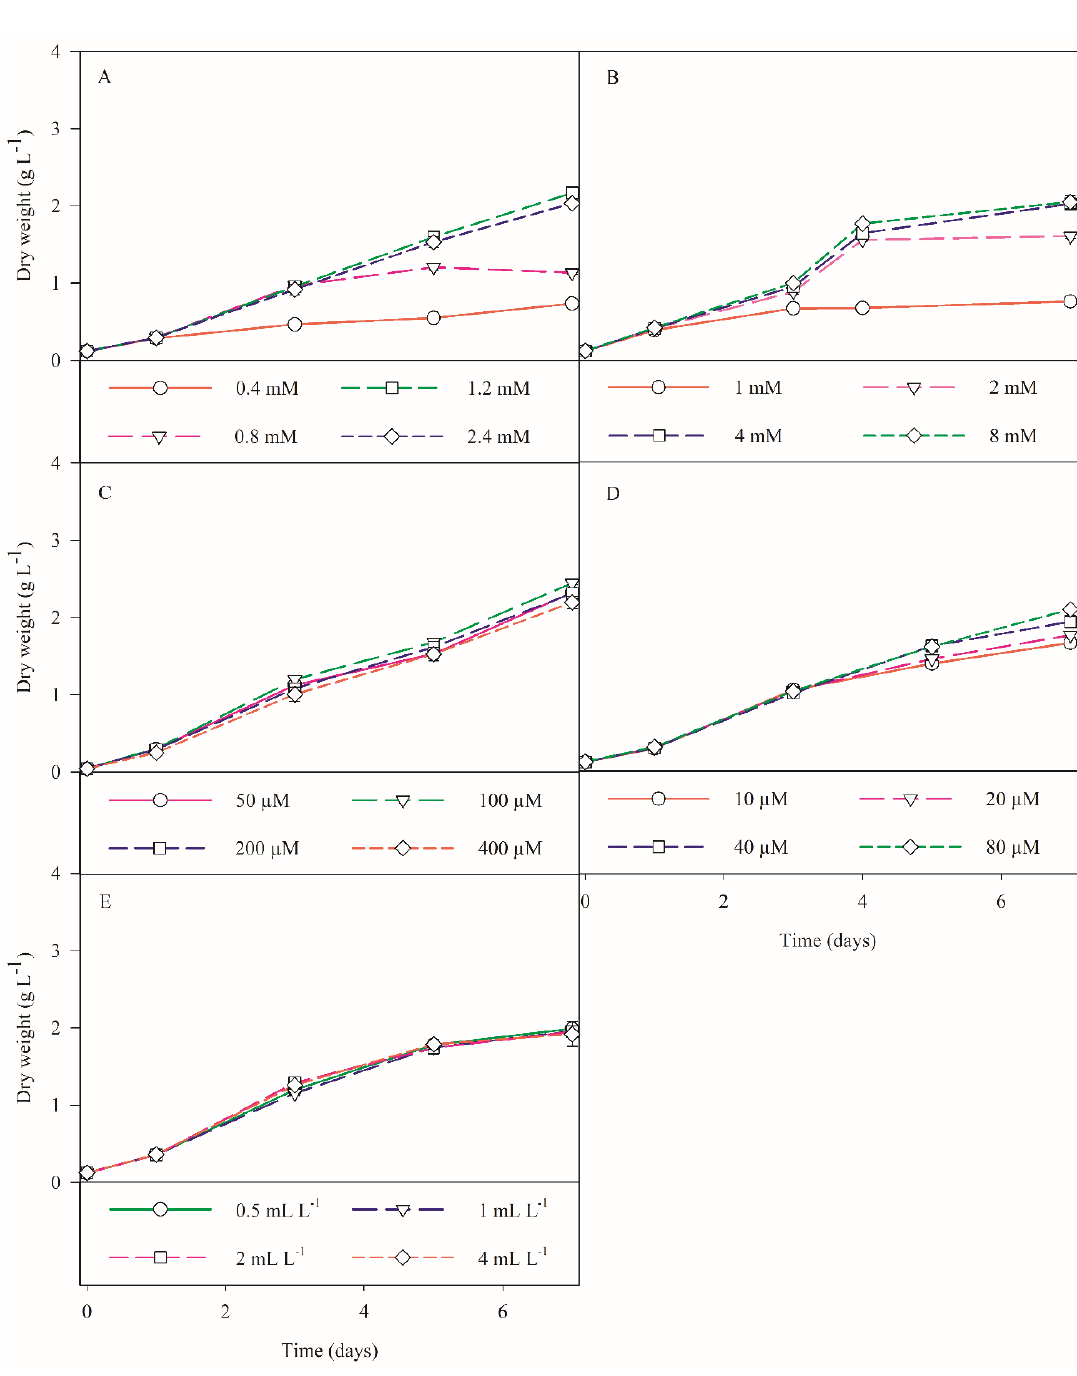
Figure 3. C. calcitrans growth performance in terms of biomass dry weight (g L − 1 ) that was obtained in 1-L bubble column PBRs in order to optimise the supply of a specific nutrient ( A ) silicate, ( B ) nitrate, ( C) phosphate, and ( D ) iron or ( E ) micronutrient concentrations ( n = 3). The values are represented as the mean ± standard deviation.